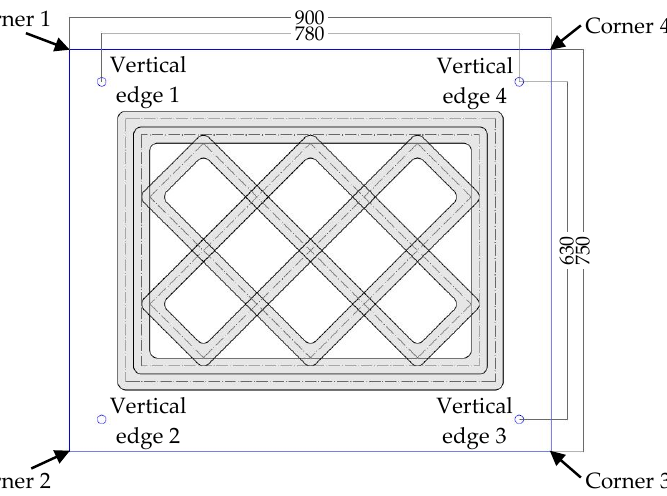
Figure 1. Dimensions of the specimen cross-section and of the 1.5 cm thick load-distribution plate.